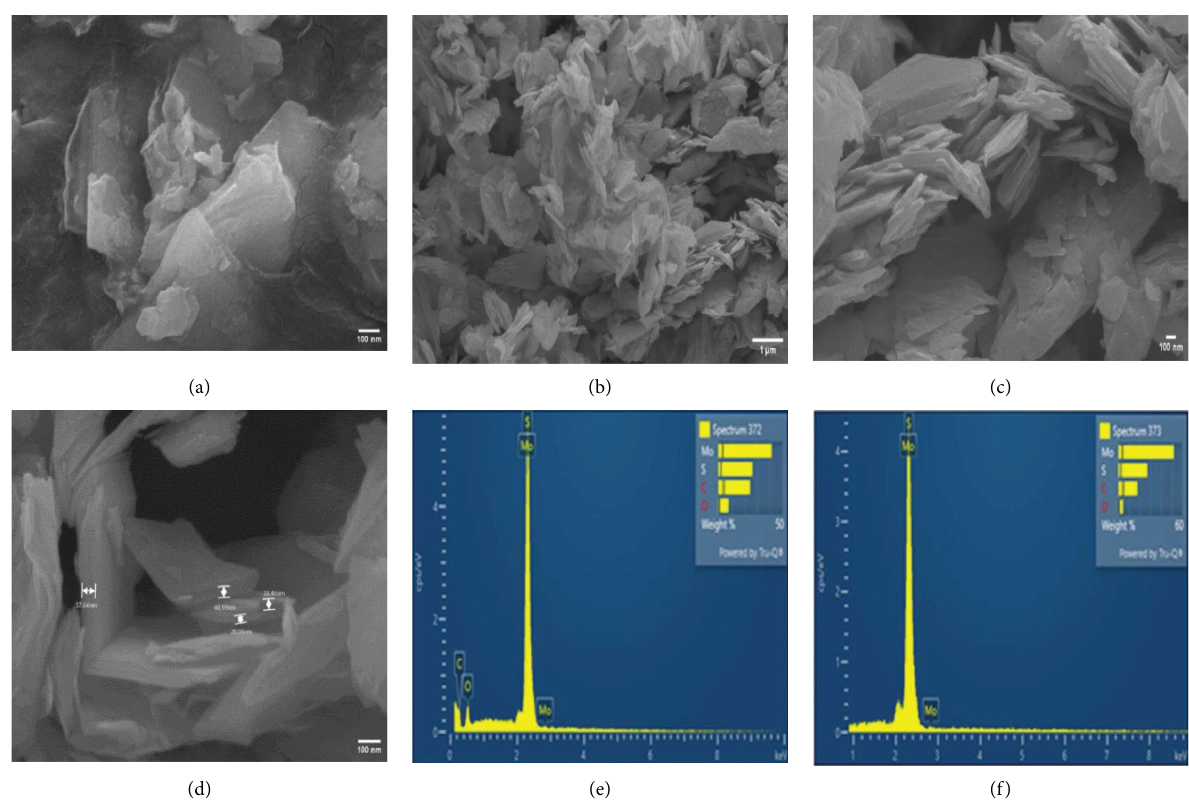
Figure 2: FESEM images of the pristine bulk and ball milling MoS 2 . (a) BL-MoS 2 100 nm scale. (b) BM-MoS 2 at 1 m scale (c and d) BM- MoS 2 at 100 nm scale. (e) EDX spectrum of BL-MoS 2 . (f) EDX spectrum BM-MoS 2